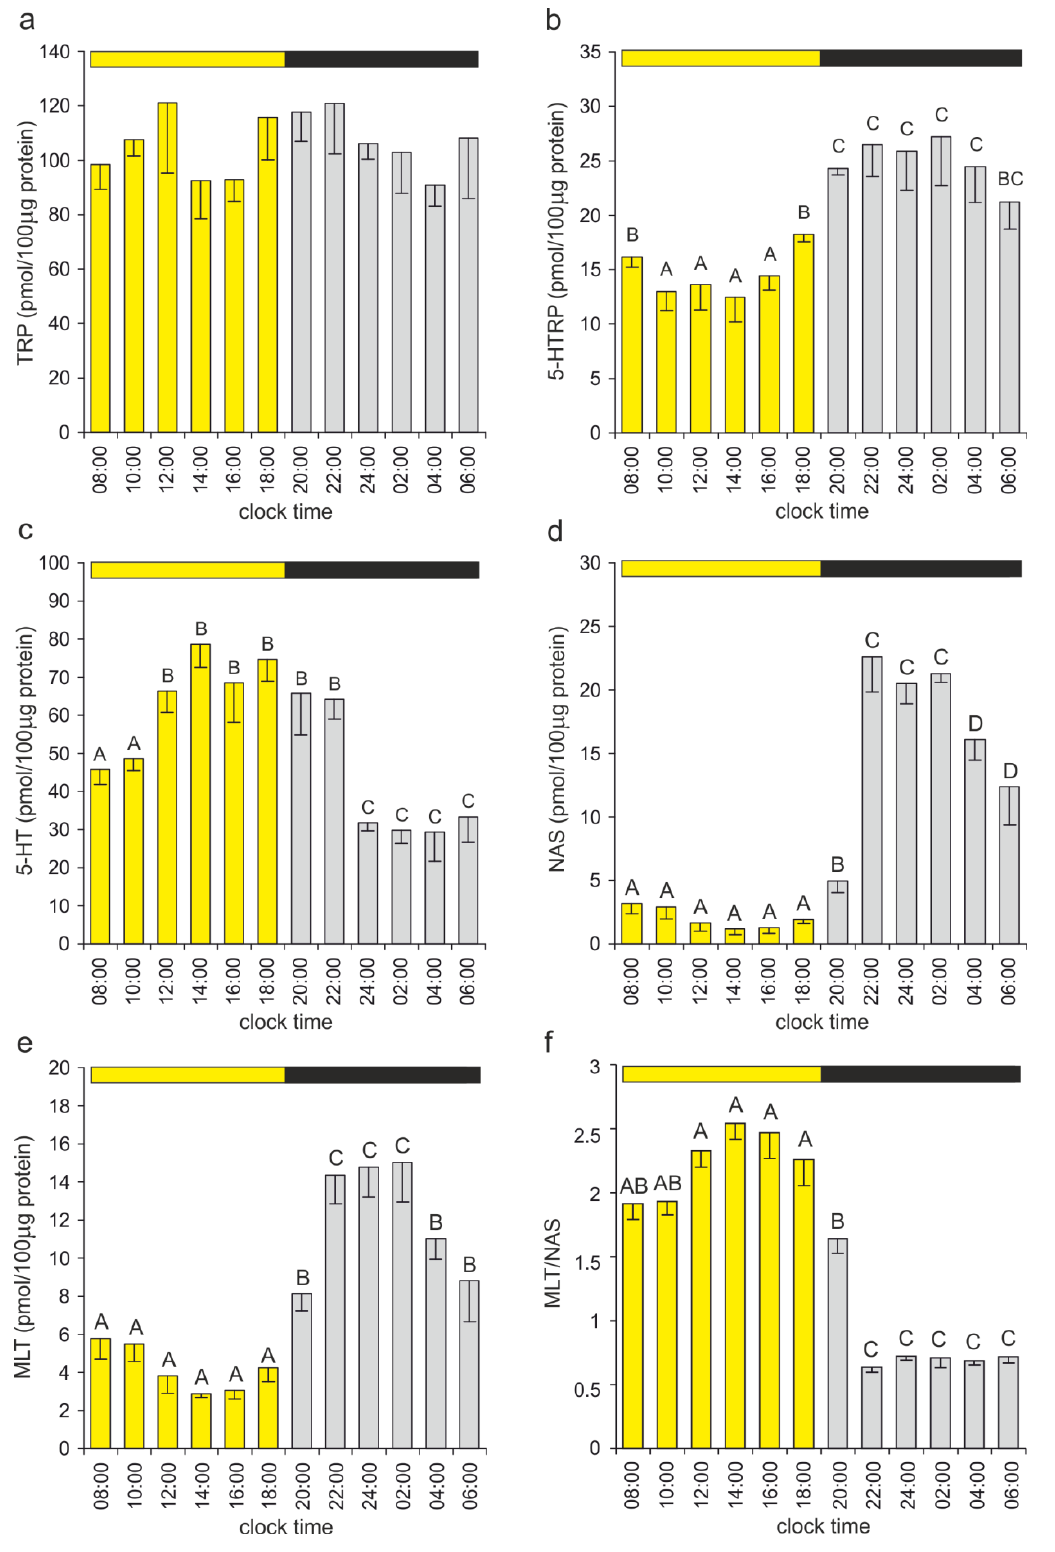
Figure 5. Indoles of the melatonin synthesis pathway. ( a  e ) The contents of TRP, 5-HTRP, 5-HT, NAS and MLT and ( f ) the MLT/NAS ratio in duck pineal organs taken at two-hour intervals over a daily cycle (means and standard errors, n = 5). The values signed with different letters are significantly different at p ≤ 0.05. Bars show the duration of the photophase (in yellow) and of the scotophase (in